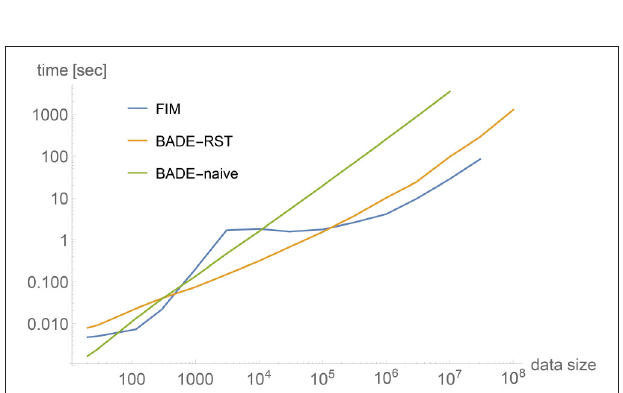
FIGURE 2 | Comparison between timings obtained by three methods applied to 2-dimensional data sets. The data sets were artificially generated to simulate a bimodal distribution, shown in Figure 3A for M 1,000. See the section on Complexity for more =